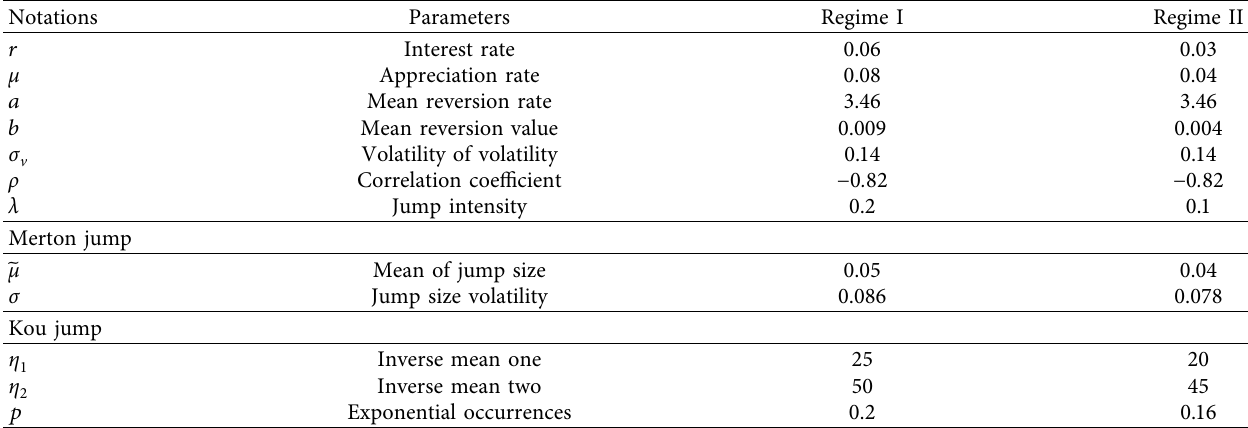
Table 1: Model parameters.